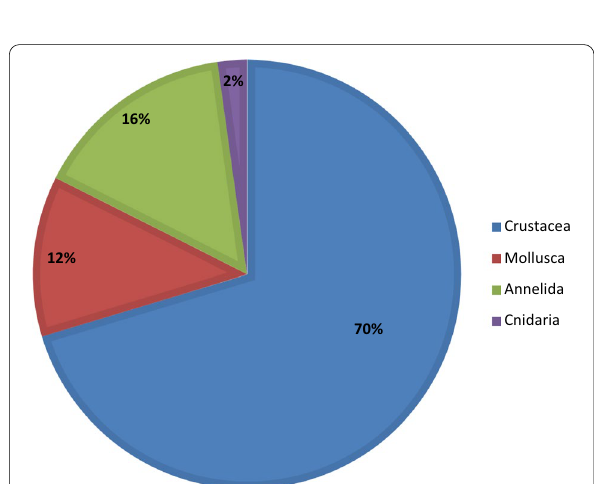
Fig. 3 Relative distributional percentages of invertebrate AIS groups originating from the Ponto‑Caspian